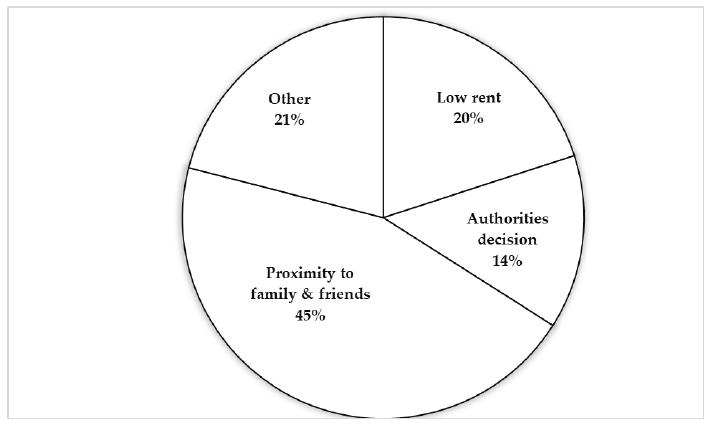
Figure 8. Reasons to live and stay in Rosengård, field survey, 2019.